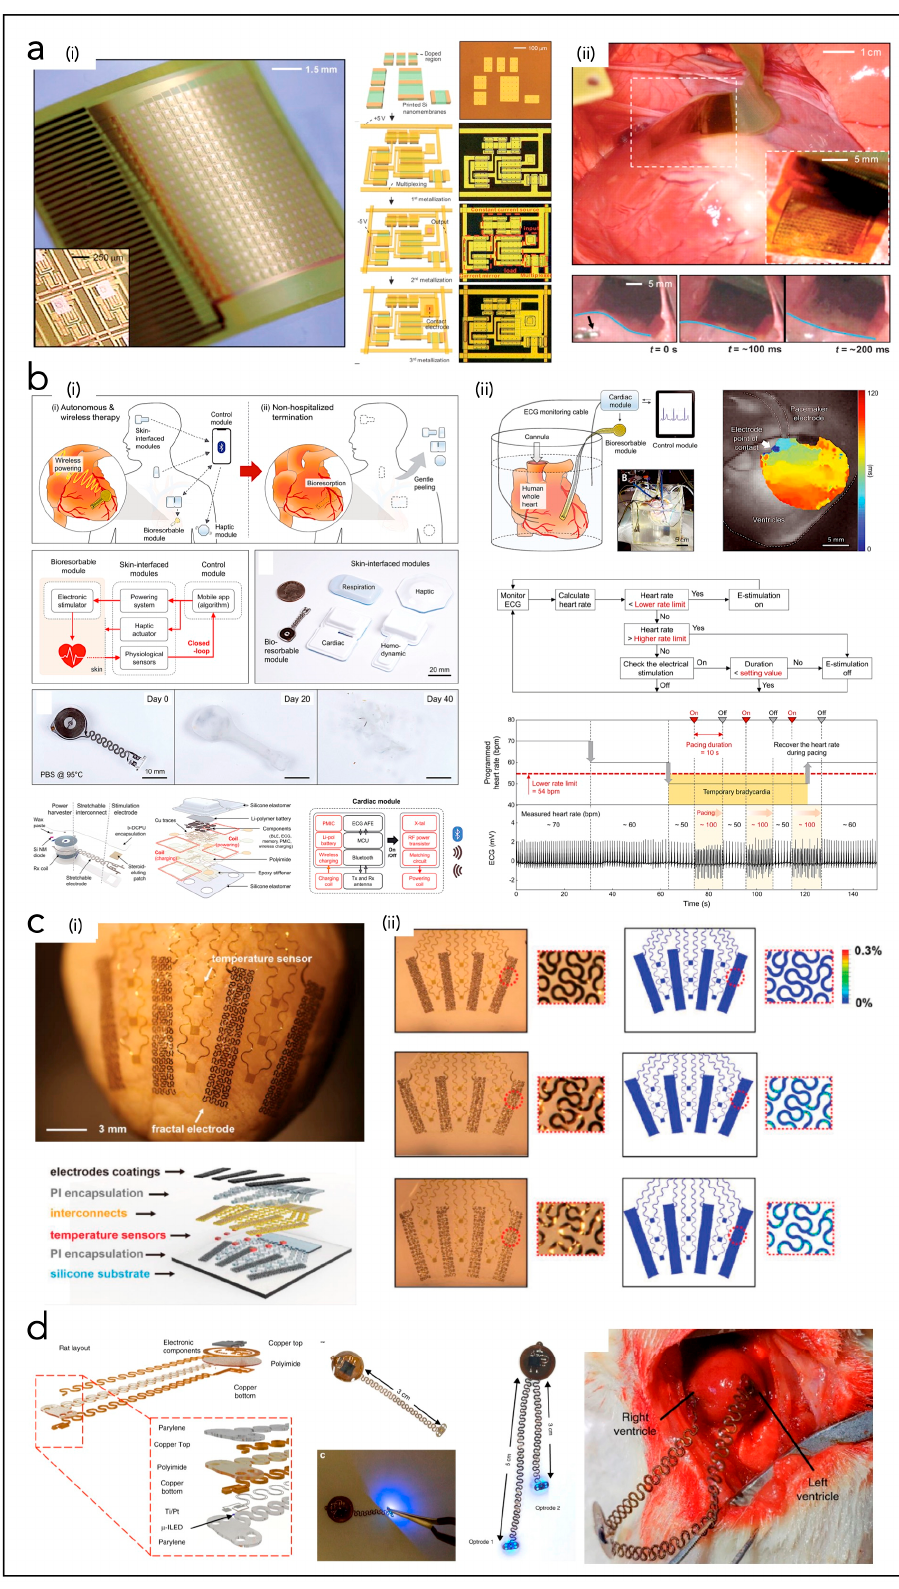
Figure 7. Epicardial bioelectronic systems. ( a ) Conformal electronics for cardiac electrophysiology based on doped silicon nanomembranes (i), implanted on a porcine heart (ii). Adapted with permission from reference [197], 2010 Copyright, The American Association for the Advancement of